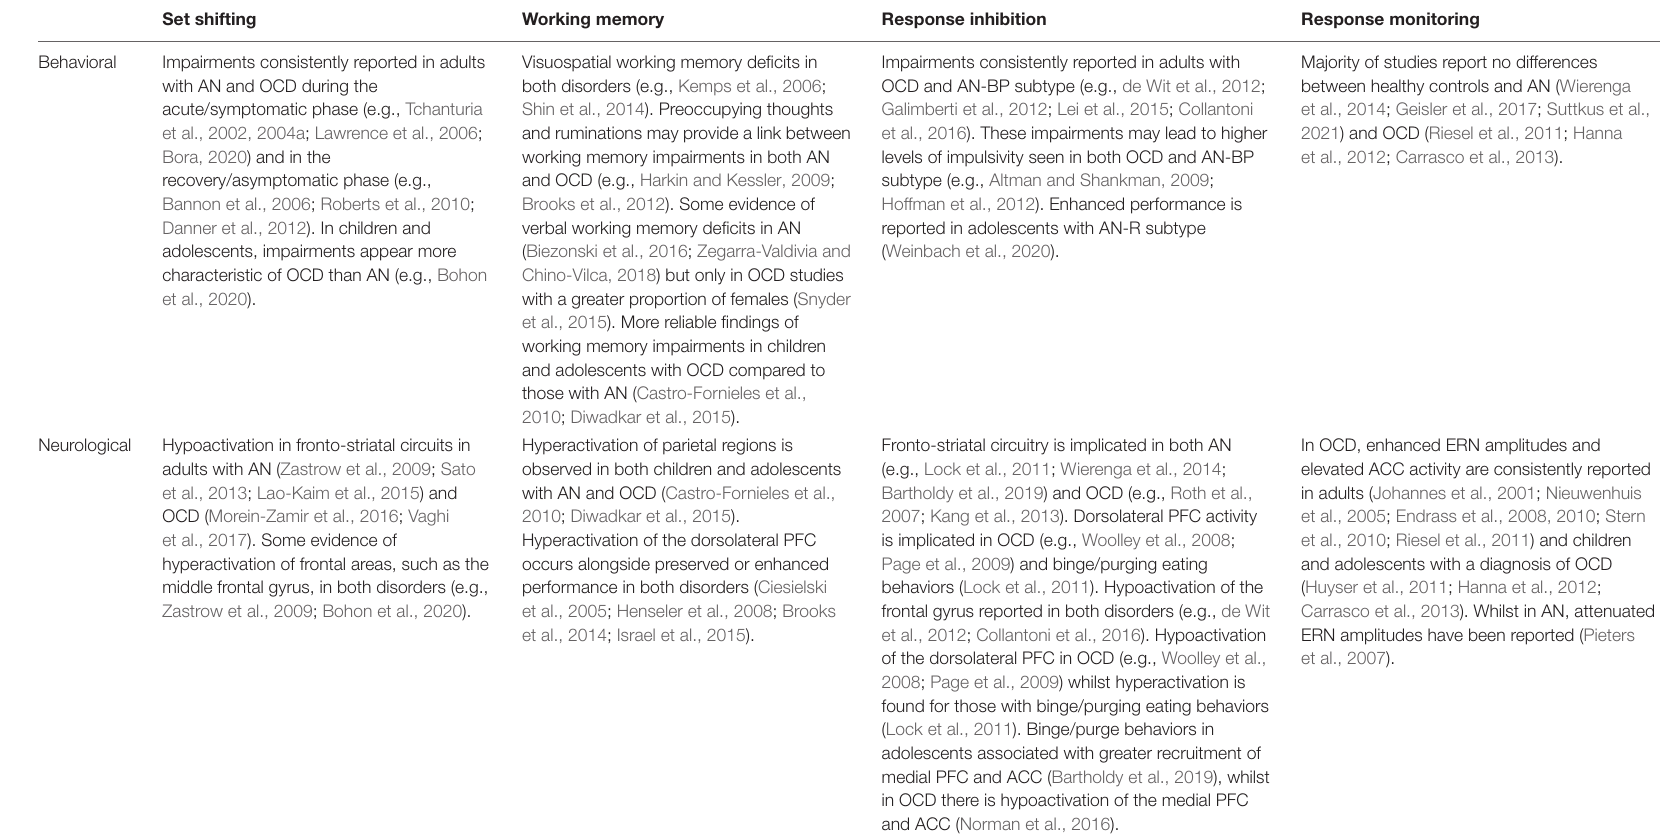
TABLE 2 | Summary of the comparison between Anorexia Nervosa (AN) and Obsessive–Compulsive Disorder (OCD) in each examined executive function. Set shifting Working memory Response inhibition Response monitoring